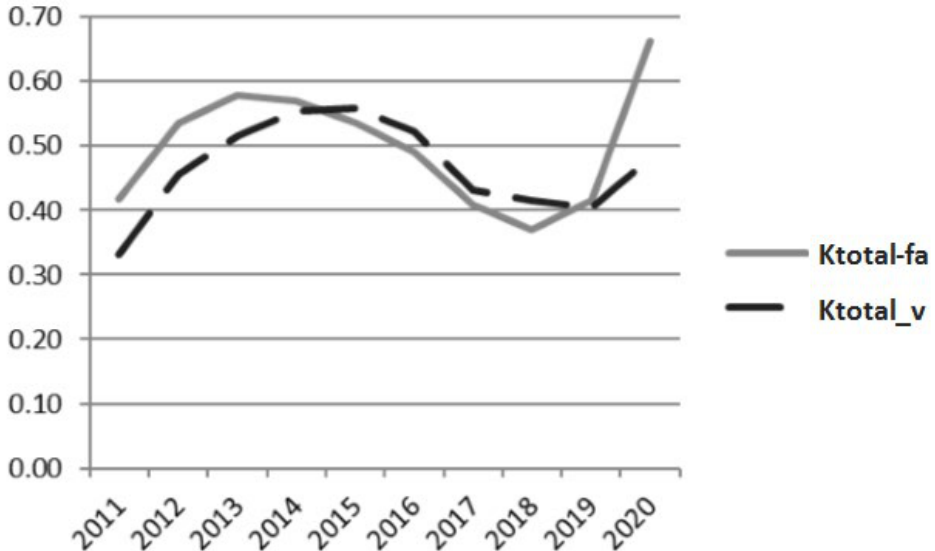
Figure 10. Ktotal value dynamics for the PJSC “Severstal”. Ktotal_fa—Ktotal for the total fixed assets; Ktotal_v—Ktotal for the total cost of machinery and equipment. Ktotal_fa and Ktotal _v were calculated based on the initial fixed assets, intangible assets, and R&D costs.